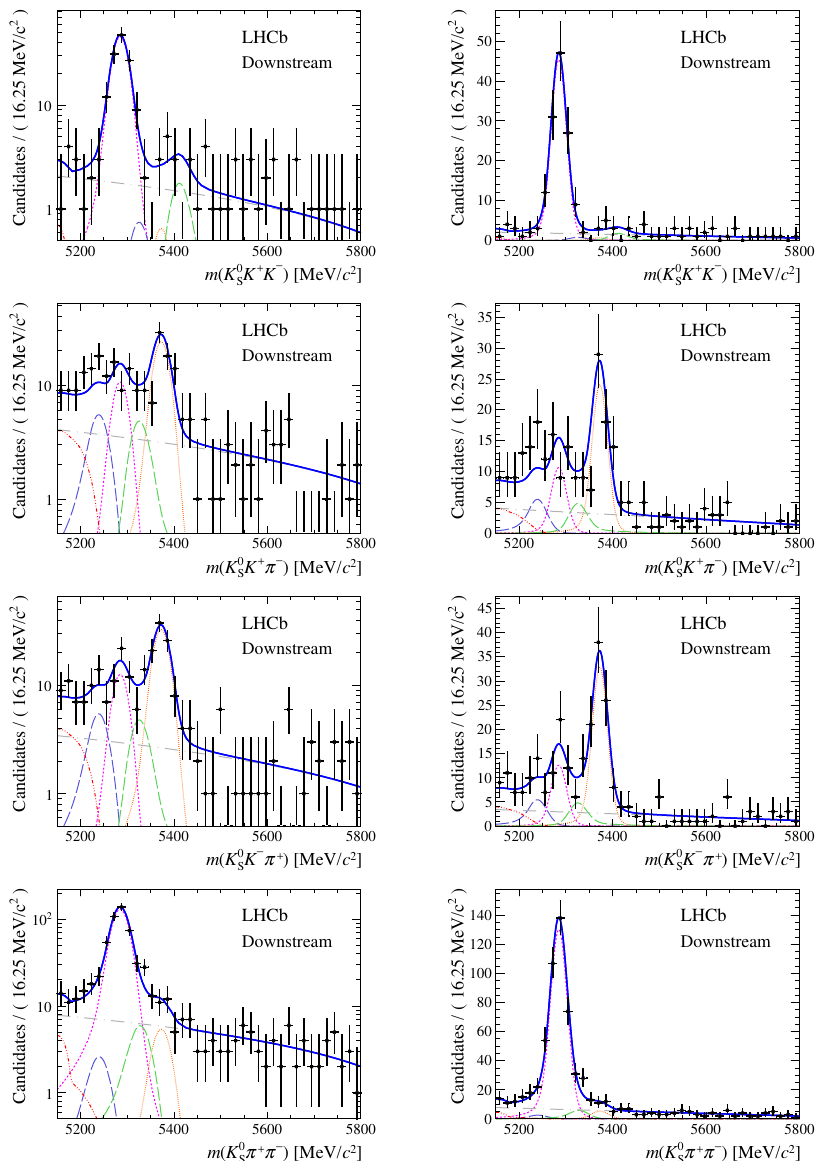
Figure 10 . Results of the simultaneous (cid:12)t to data (downstream, 2012a) with the BDT optimisation corresponding to the suppressed modes. The modes K 0 are shown from top to bottom. The left-hand side plots show the results with a logarithmic scale and the right-hand side with a linear scale. Legend is similar to that of plots shown in (cid:12)gure 1.